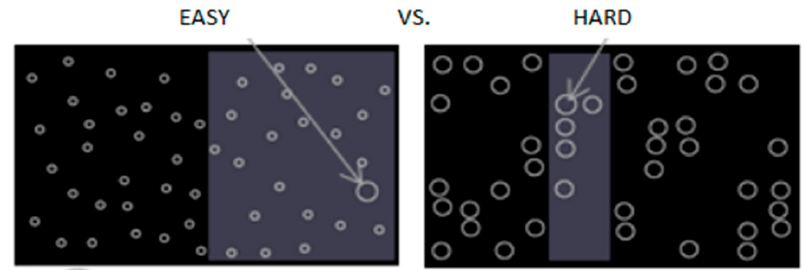
Figure 5. Visual-manual Surrogate Reference Task (SuRT) [30].